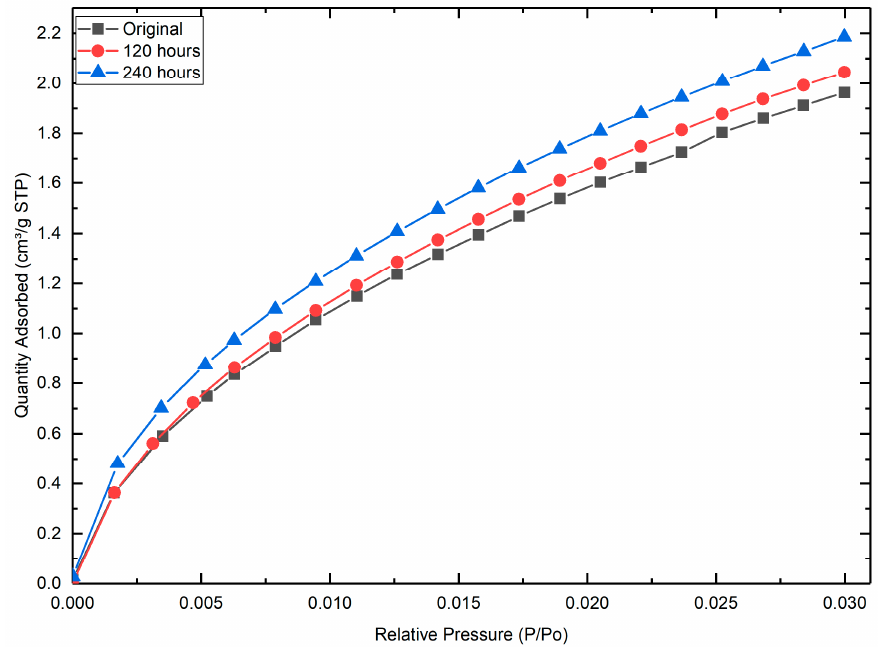
Figure 7. CO 2 adsorption isotherms of the pre- and post-test samples.